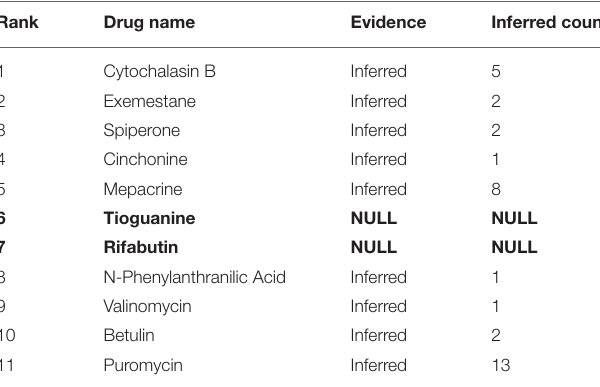
TABLE 3 | Eleven aggravating drugs for HCC in the Top-30 drugs.